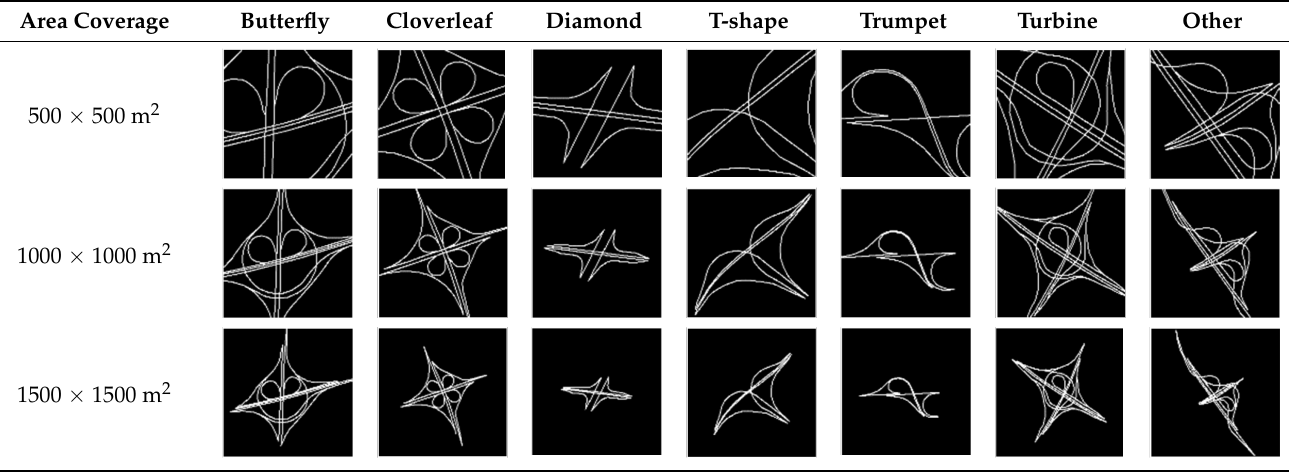
Table 1. Examples of the seven types of junction samples under three sampling area